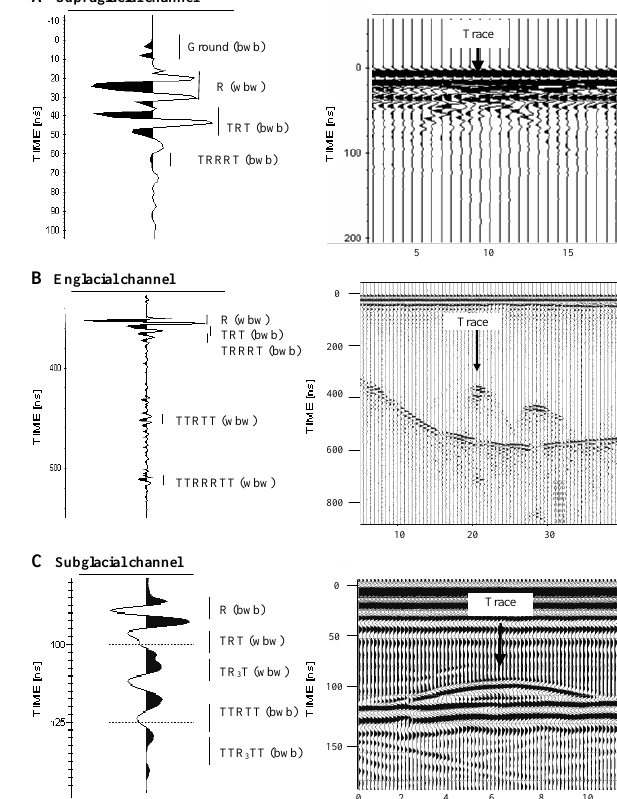
Fig. 7. Wavelet traces and GPR profiles from drainage channels. Vertical scale is in ns TWT, horizontal in m. (A) ca. 2m deep, lateral melt water channel. The curvature of the hyperbola indicates a velocity of around 0.22m/ns, a reasonable value for a snow filled channel. (B) Englacial channel. Detail from a cross glacier line. The radar signature can be interpreted as a 2/3 water filled englacial channel ca. 2.3m in diameter. (C) Partially water filled subglacial channel near the terminus. A and B are from the 2009 data set, C is from